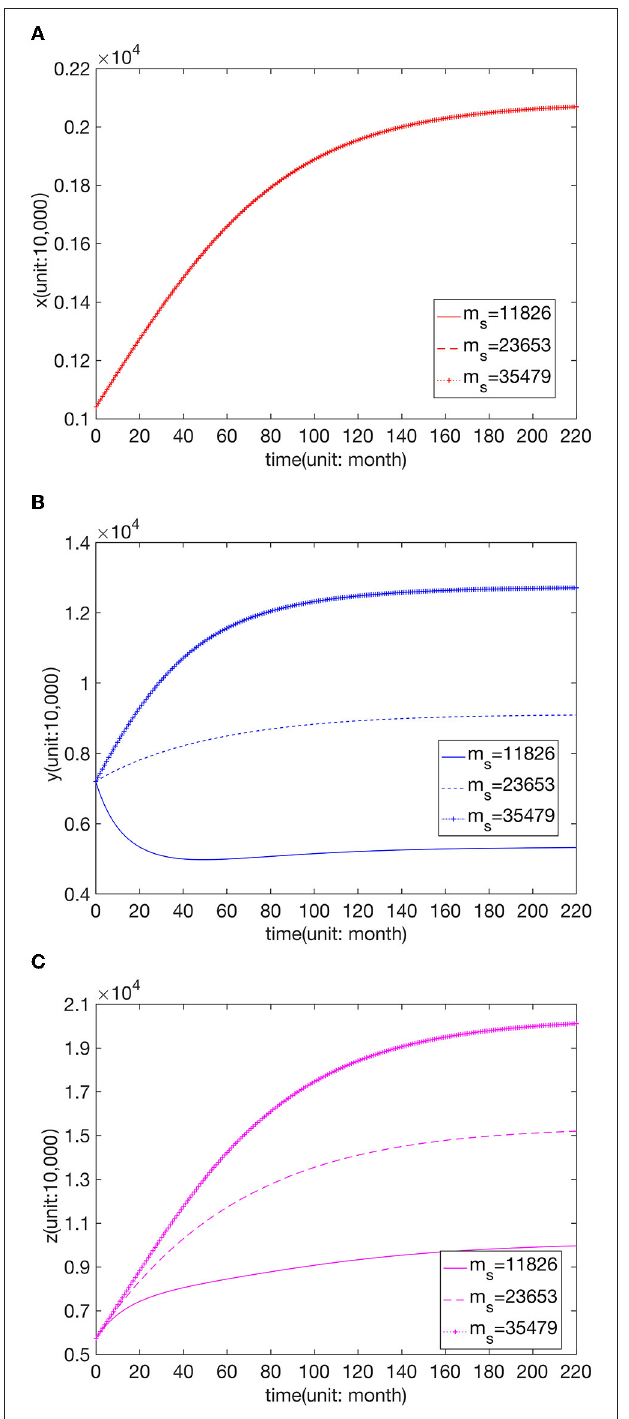
FIGURE 7 | Effect of parameter value m s on the number of visits to (A) FLHs, (B) SLHs, and (C) TLHs. levels, we kept the other parameters unchanged and conducted a numerical simulation for the three cases with the maximum patient capacities of 0.5, 1, and 1.5 times, respectively.